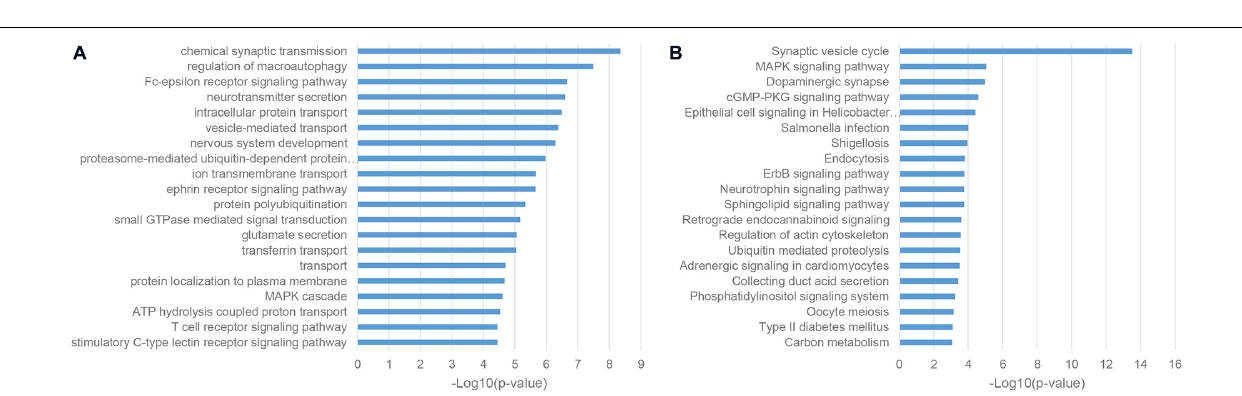
FIGURE 4 | Enriched functional terms of gene co-expression neighbors of ASD-related lncRNAs. (A) The top 20 GO BP terms with p -value < 0.05. (B) Top 20 KEGG pathway terms with p -value <